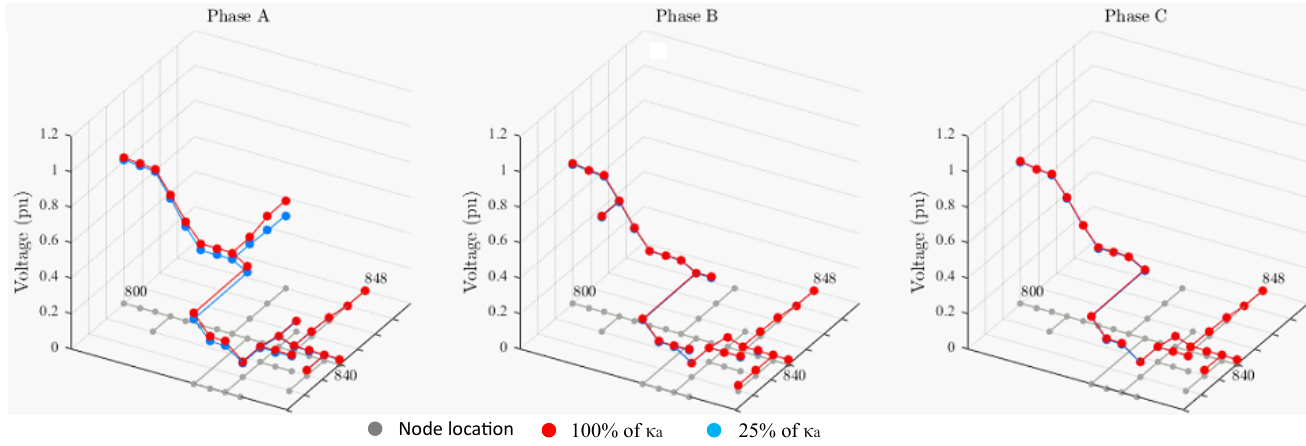
Figure 16. Voltage profile using the proposed method for three-phase fault.